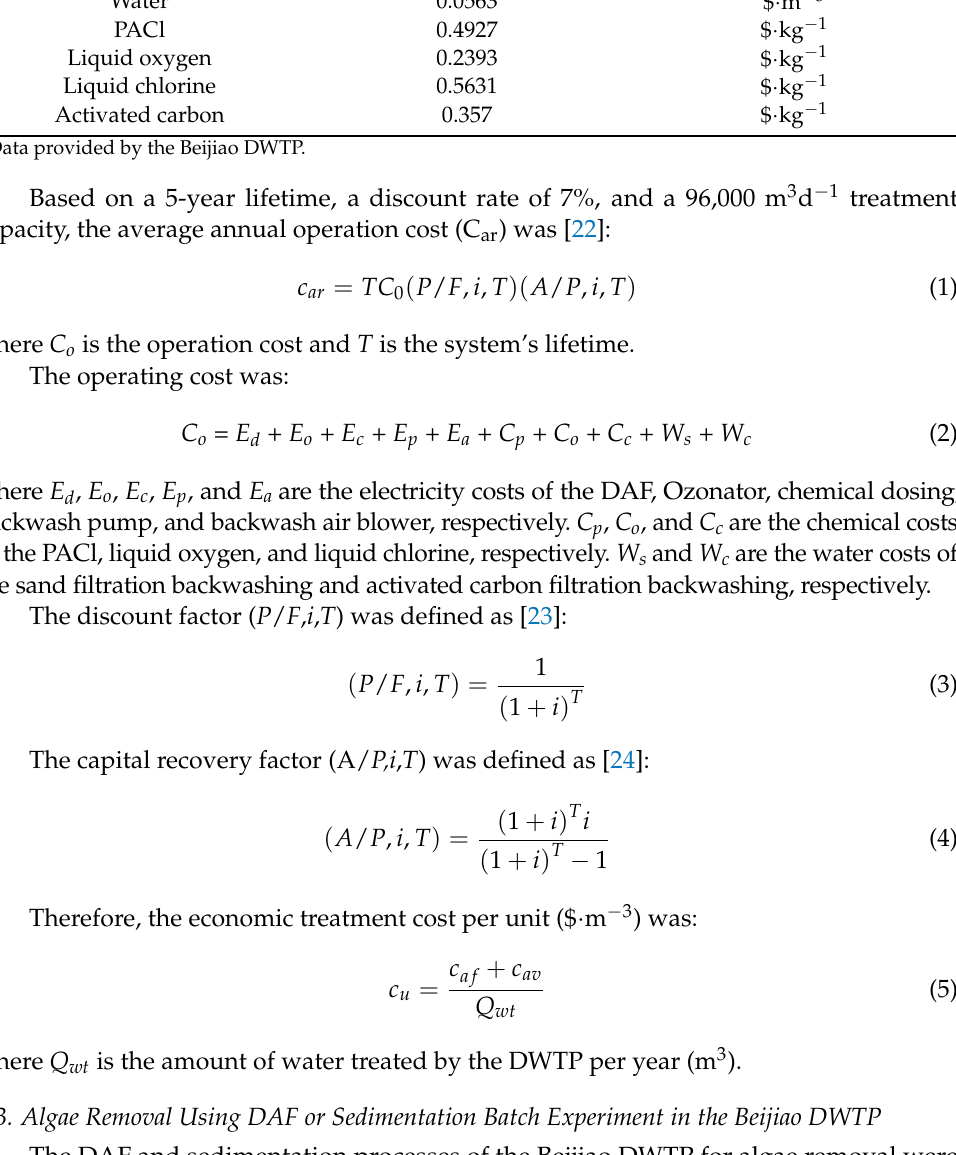
Table 2. The unit costs of the electricity and chemicals *. Parameters Value Unit Electricity 0.1126 $ · kwh − 1 Water 0.0563 $ · m − 3 PACl 0.4927 $ · kg − 1 Liquid oxygen 0.2393 $ · kg − 1 Liquid chlorine 0.5631 $ · kg − 1 Activated carbon 0.357 $ · kg −